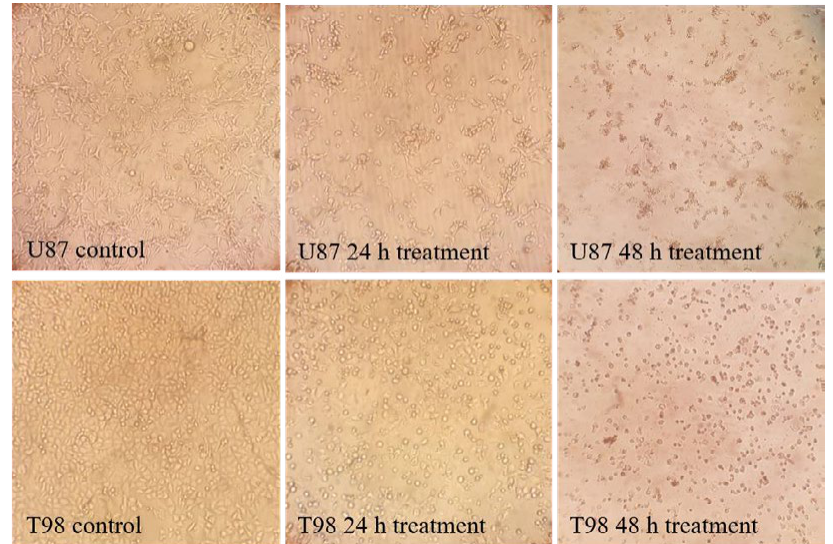
Fig. 3: Effect of PTX cytotoxicity on U87 and T98 cell lines